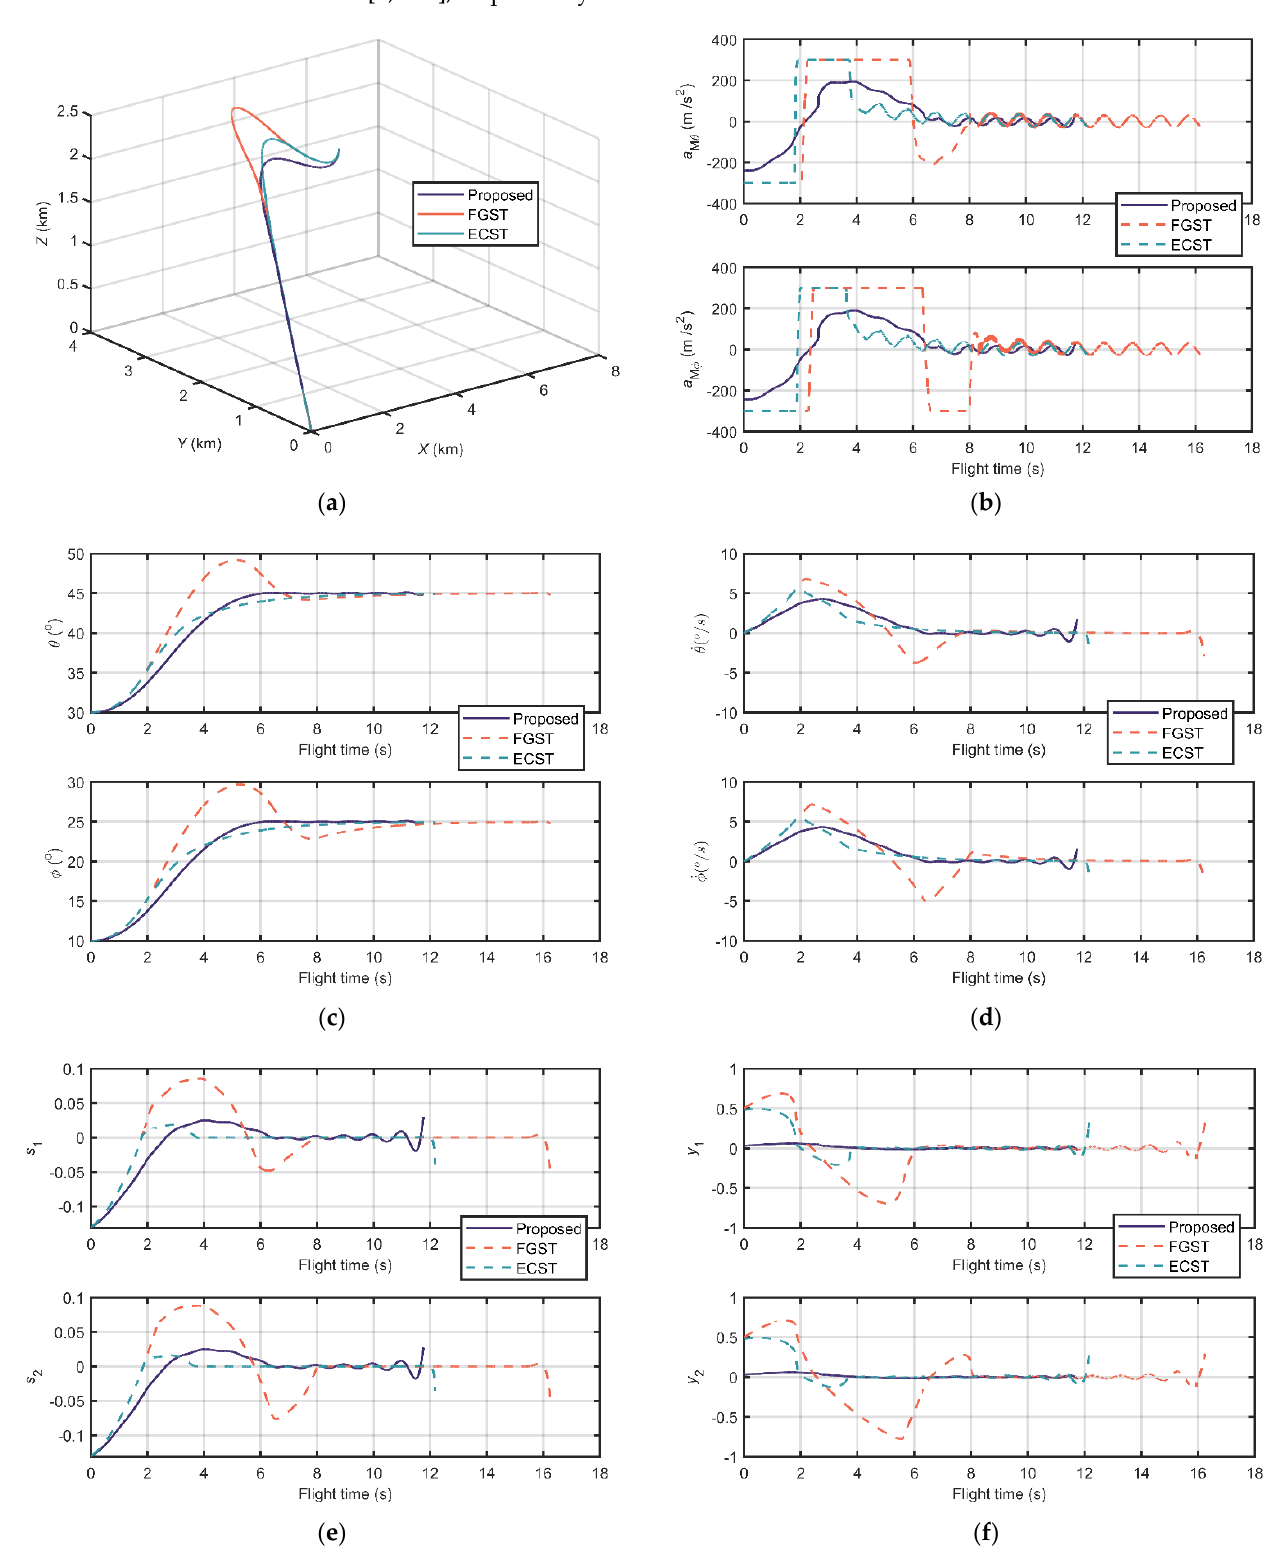
Figure 6. Comparison results of case 1: ( a ) Relative distance trajectories; ( b ) Acceleration commands; ( c ) LOS angles; ( d ) LOS angular rates; ( e ) The sliding manifold; and ( f ) The state variable y ( t )